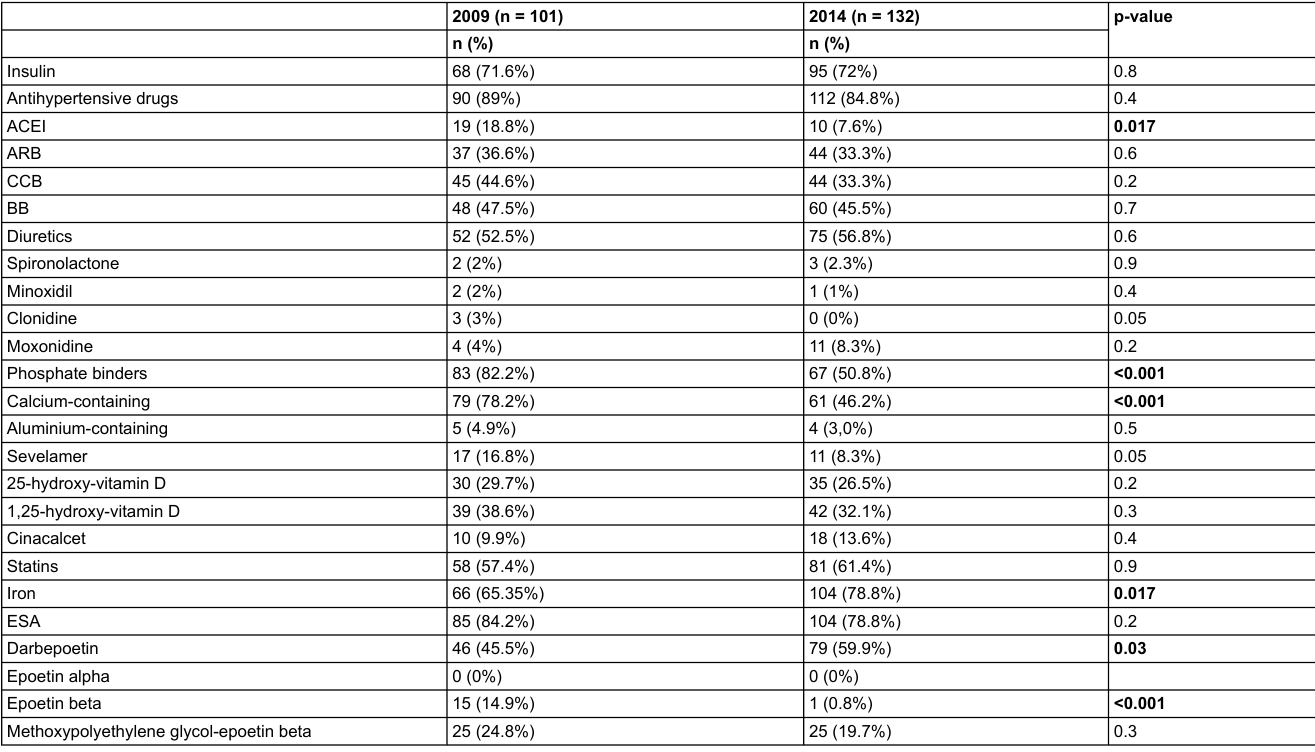
Table 3: Medications used by end-stage renal disease patients with diabetes in 2009 and